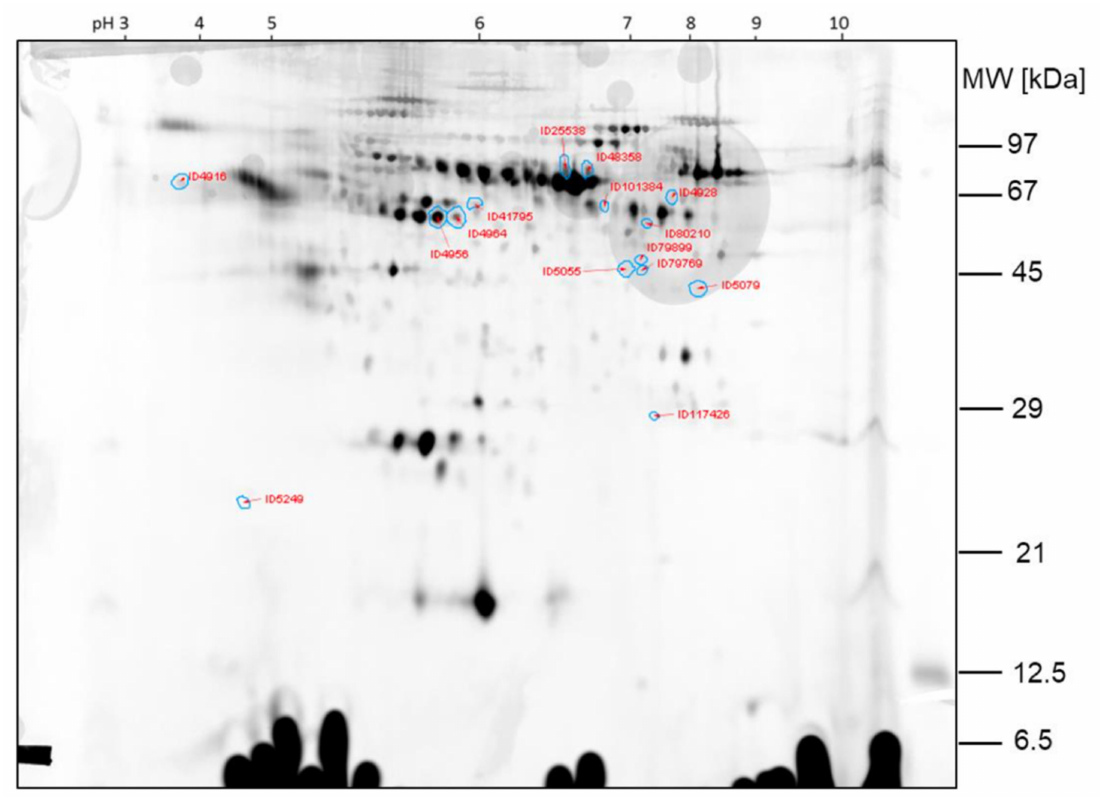
Figure 7. Comparison 2: Spots found >2-fold higher expressed in GC60.